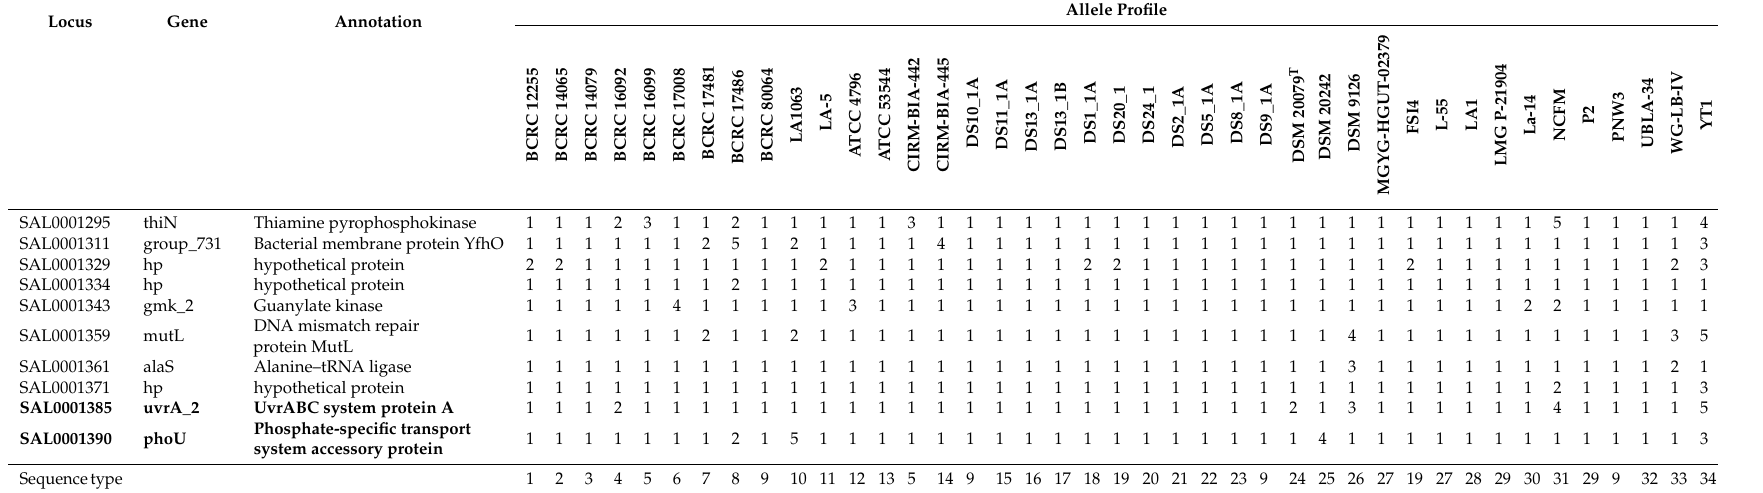
The bold letters indicate the genes used for the validation of reference strains. BCRC: Bioresource Collection and Research